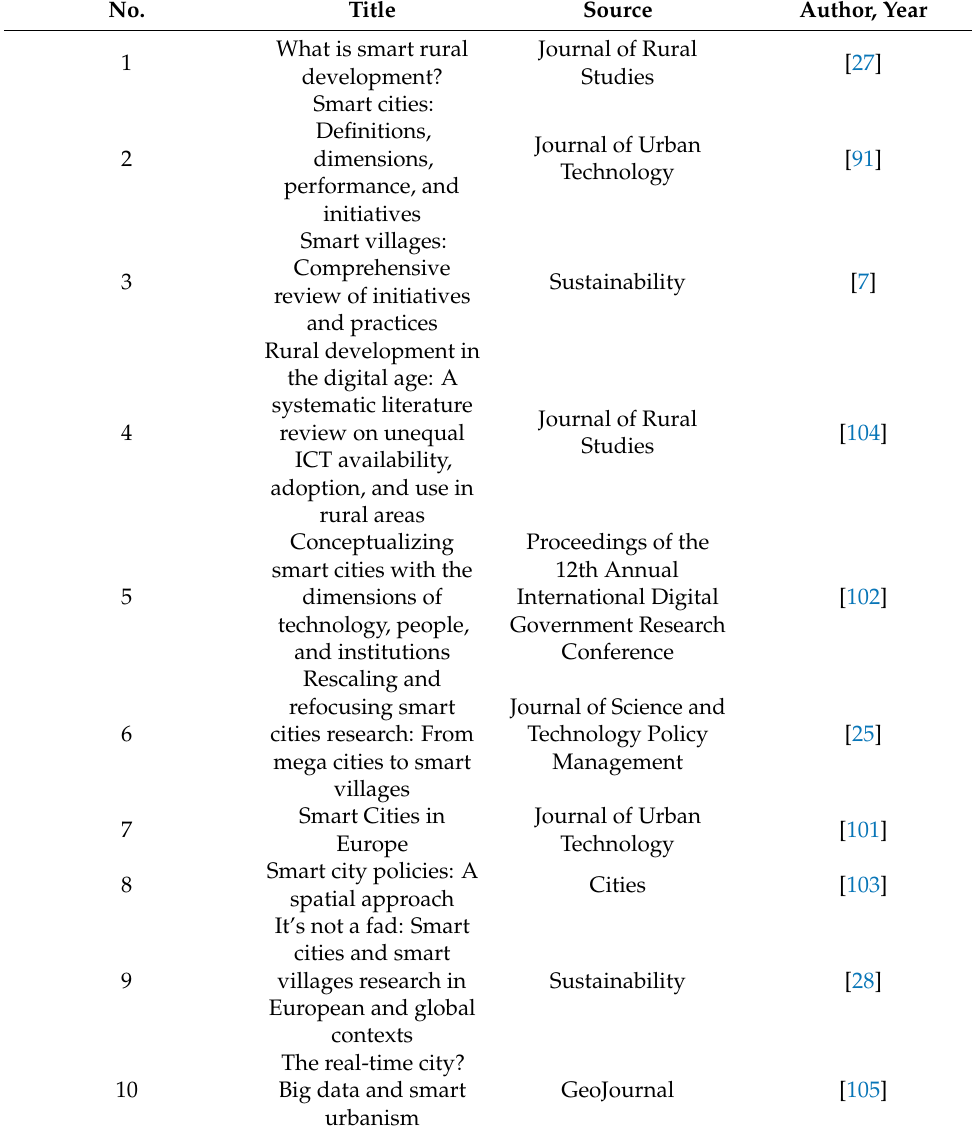
Table 6. Top 10 most relevant